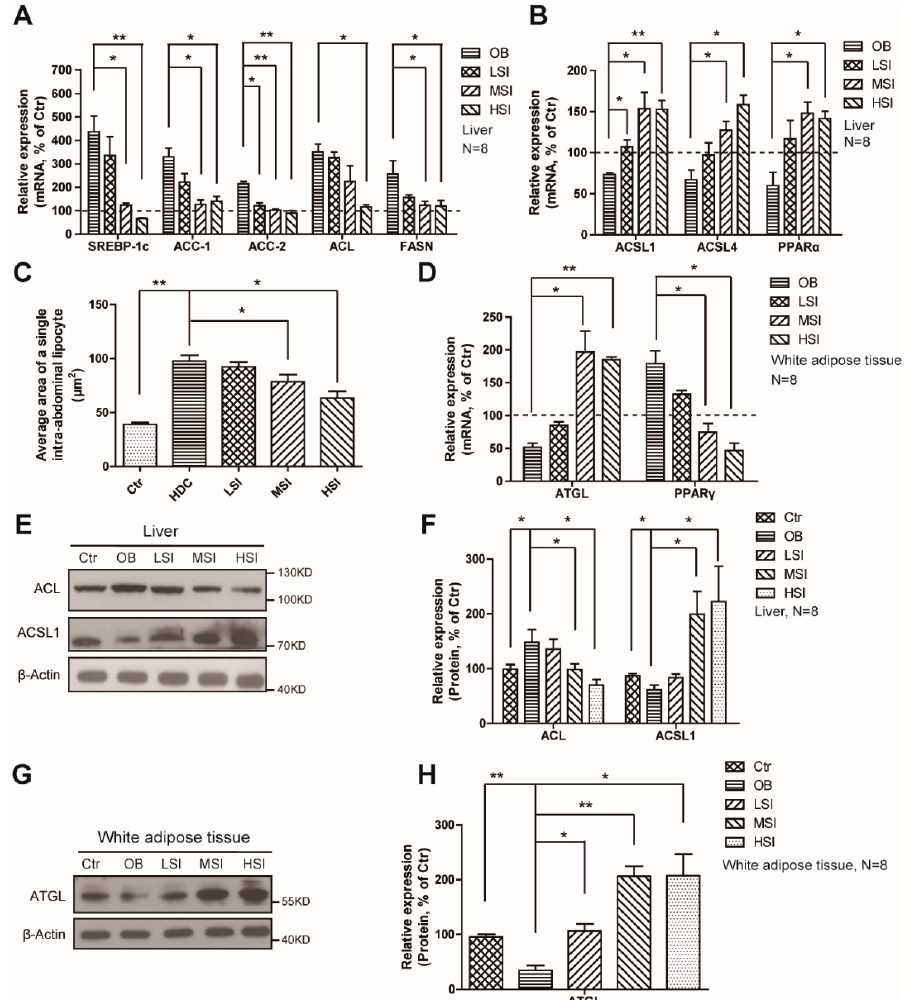
Figure 3 . Soy isoflavones suppress lipogenesis and adipogenesis, and enhance lipolysis and β -oxidation in DIO rats. ( A ) qRT-PCR shows decreased mRNA levels of the lipogenesis-related genes as indicated in liver of the soy isoflavone-fed DIO rats in comparison to the OB group; ( B ) qRT-PCR shows increased mRNA levels of the β -oxidation related genes as indicated in liver of the soy isoflavone-fed DIO rats in comparison to OB group; ( C ) Quantification shows changes of the average area of a single intra-abdominal lipocyte in rats fed different diets; ( D ) qRT-PCR shows increased mRNA levels of ATGL, while a decreased mRNA levels of PPAR γ , as indicated in white adipose tissue of the soy isoflavone-fed DIO rats in comparison to the OB groups; ( E , F ) Western blots and quantification show an increase in ACL, and a decrease in ACSL1 in the liver of the soy isoflavone- fed DIO rats in comparison to the OB group; ( G , H ) Western blots and quantification show an increase in ATGL in the liver of the soy isoflavone-fed DIO rats in comparison to the OB group. Error bars indicate SEM. * p < 0.05, ** p < 0.01. The dashed shows the ctr.